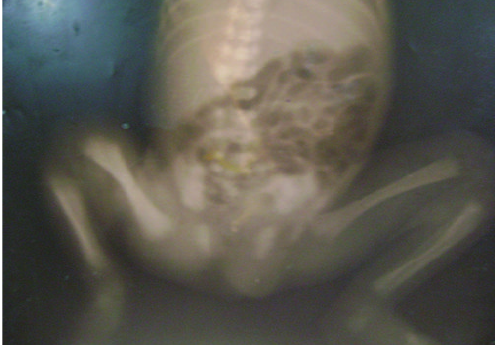
Figure 4: Radiograph of long bones: distal end of femur showing erosions.